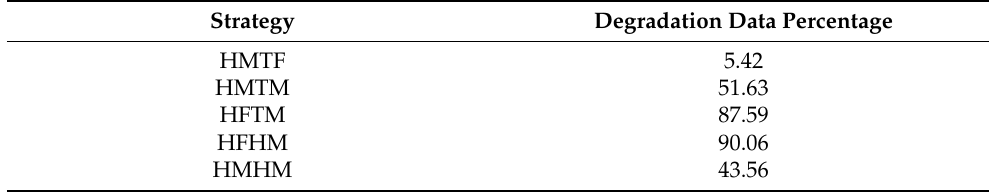
Table 4. Window moving strategies